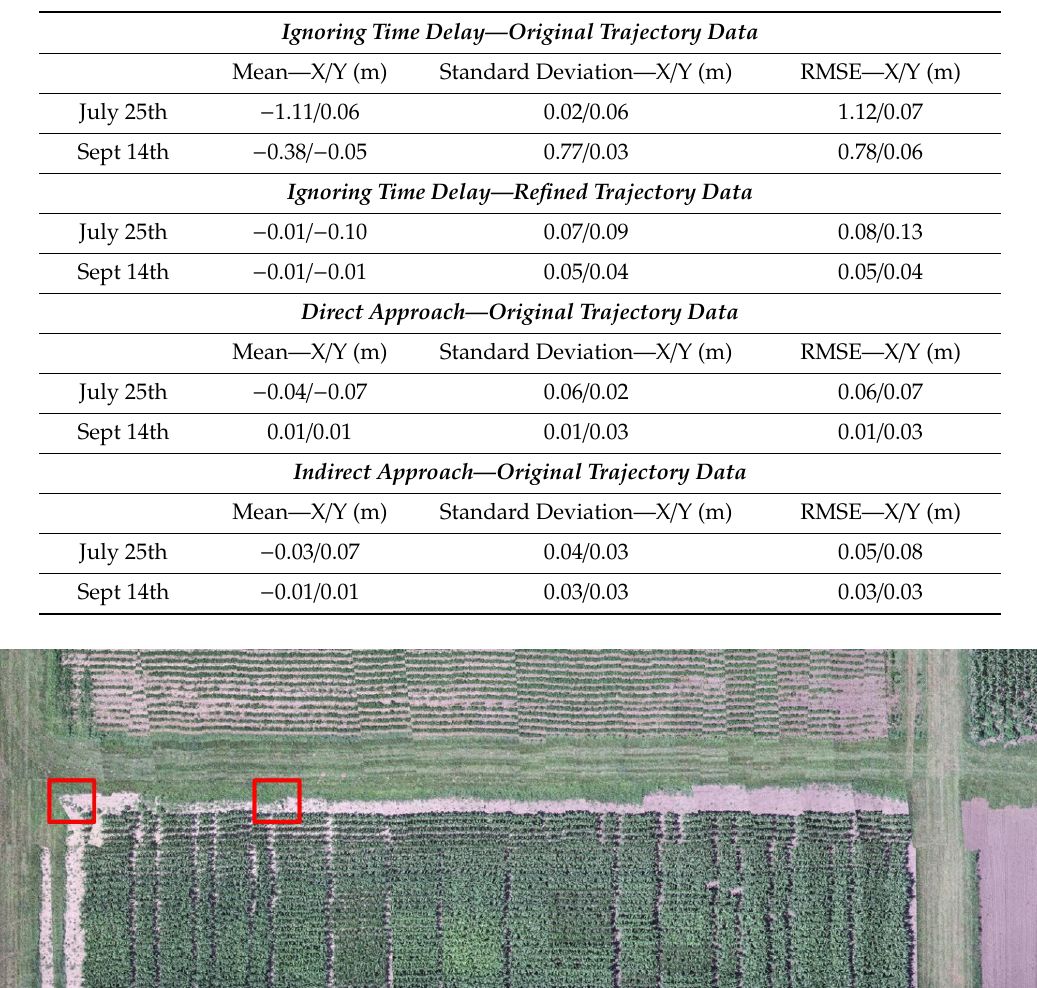
Figure 21. Orthophoto result ignoring the time delay using the original trajectory data for FLIR RGB July 25th data collection (red boxes show the location of the check points—only two visible, Original Image GSD ≈ 0.01 m